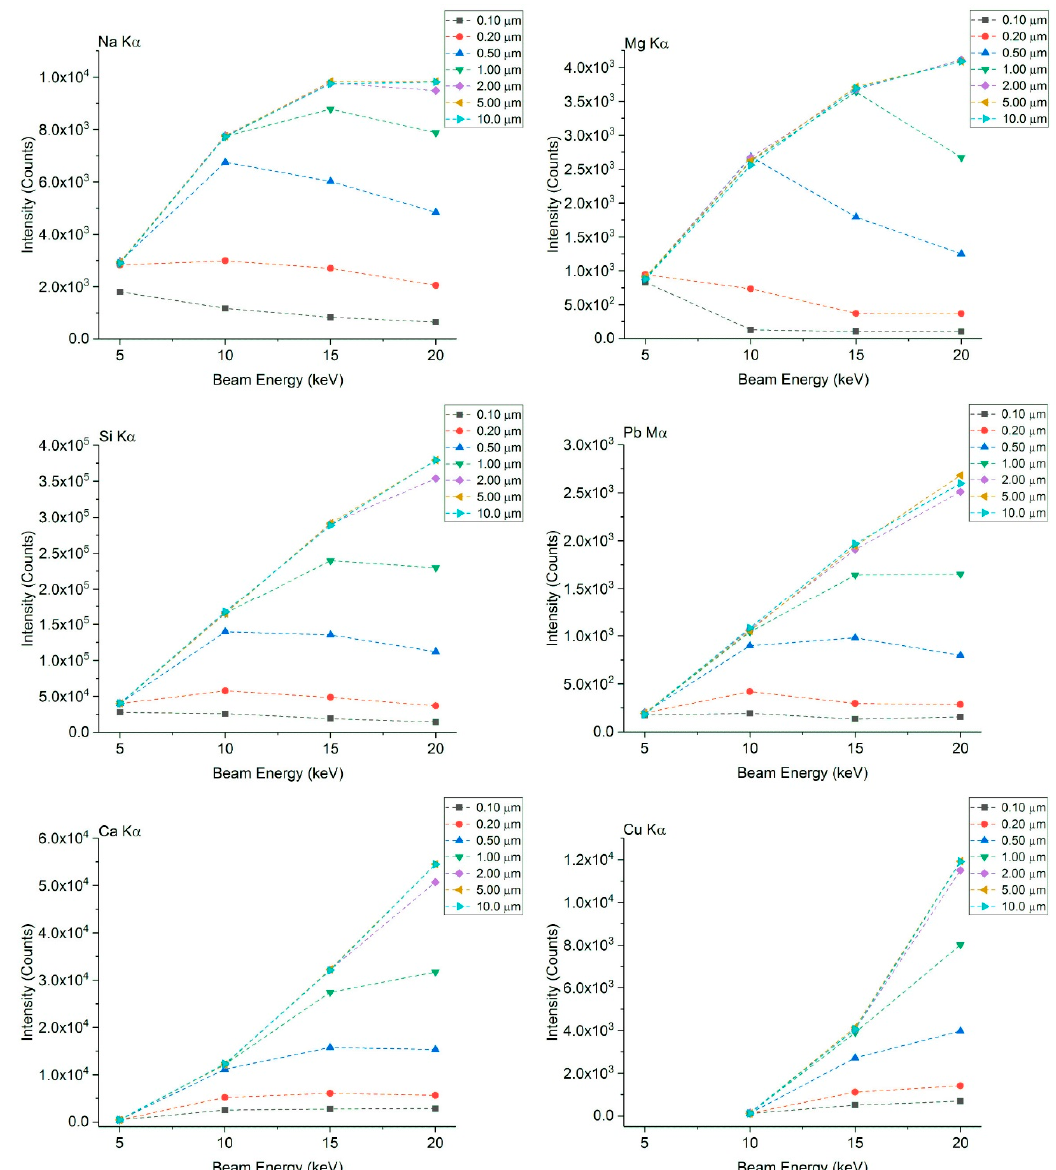
Figure 6. Simulated SEM-EDS X-ray intensity (K α lines for Na, Mg, Si, Ca and Cu, and Pb M α ) as a function of thickness and beam energy for an Egyptian blue sample of prismatic shape placed onto an Al substrate (according to the scheme of Figure 2). The statistical variation for each point is of the order of 1%.